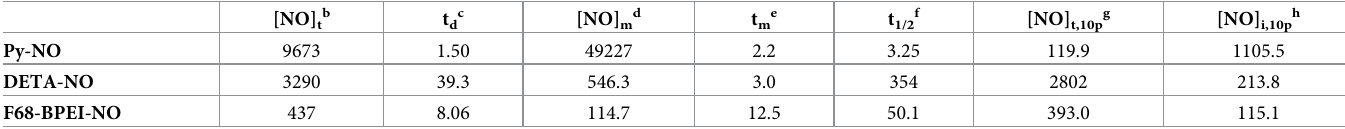
Table 1. NO release properties of tested materials a